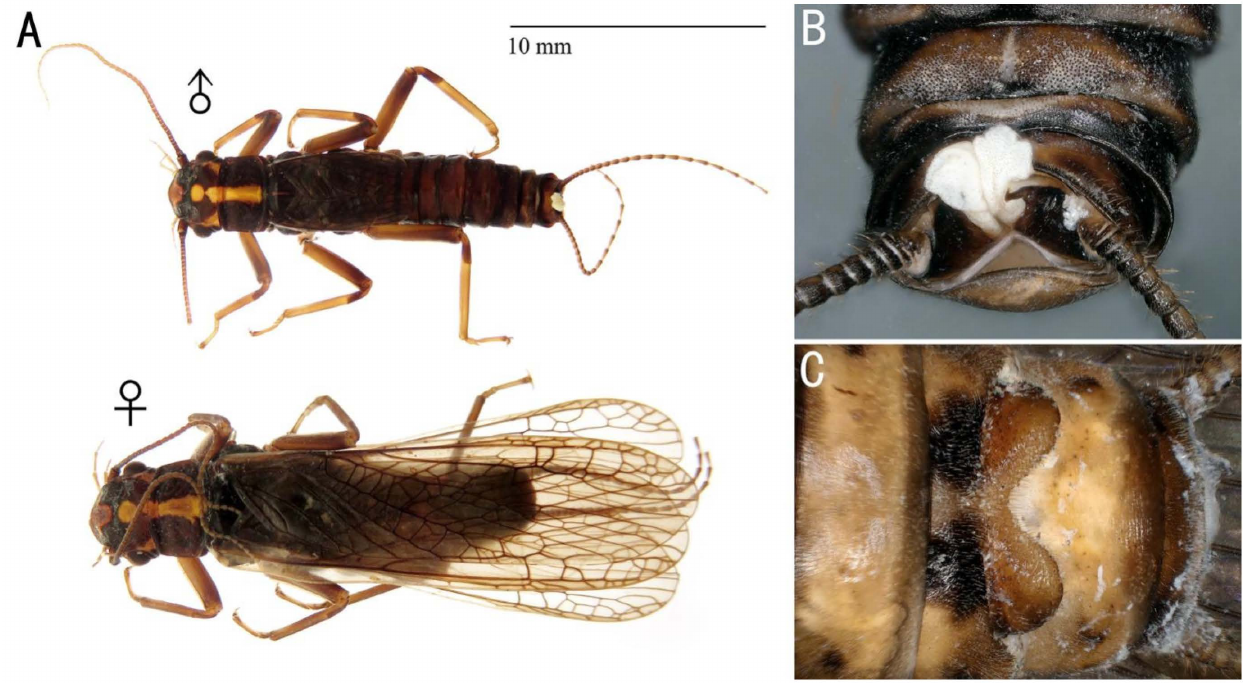
Figure 3. Filchneria mongolica . ( A ): male and female habitus; ( B ): male terminalia, dorsal; ( C ): female terminalia,